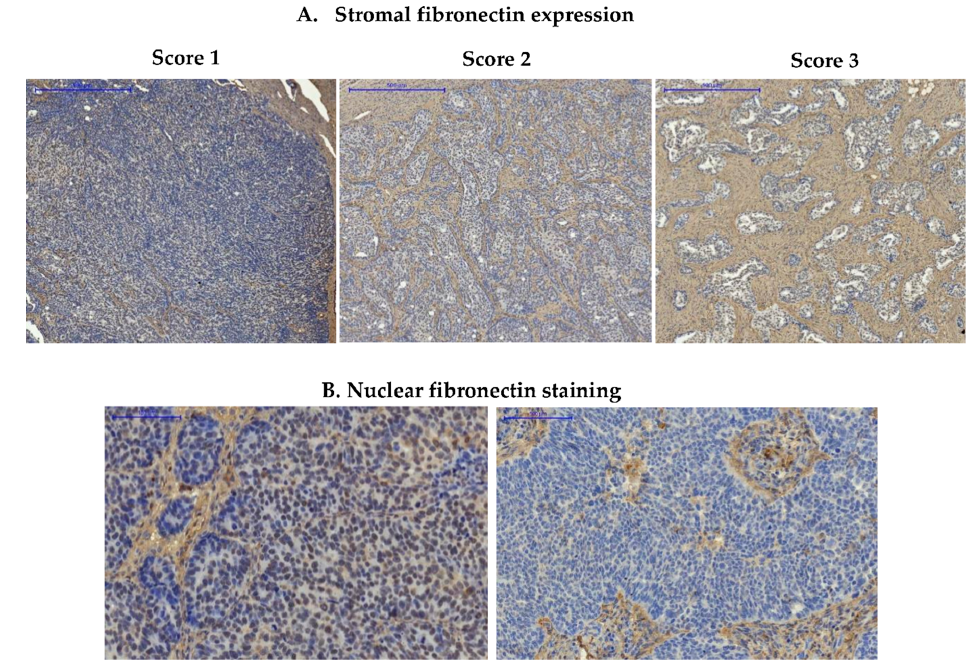
Figure 1. Immunohistochemical detection of fibronectin in ovarian cancer samples. ( A ) Images show representative examples of stromal fibronectin staining, scored as 1 (weak expression), 2